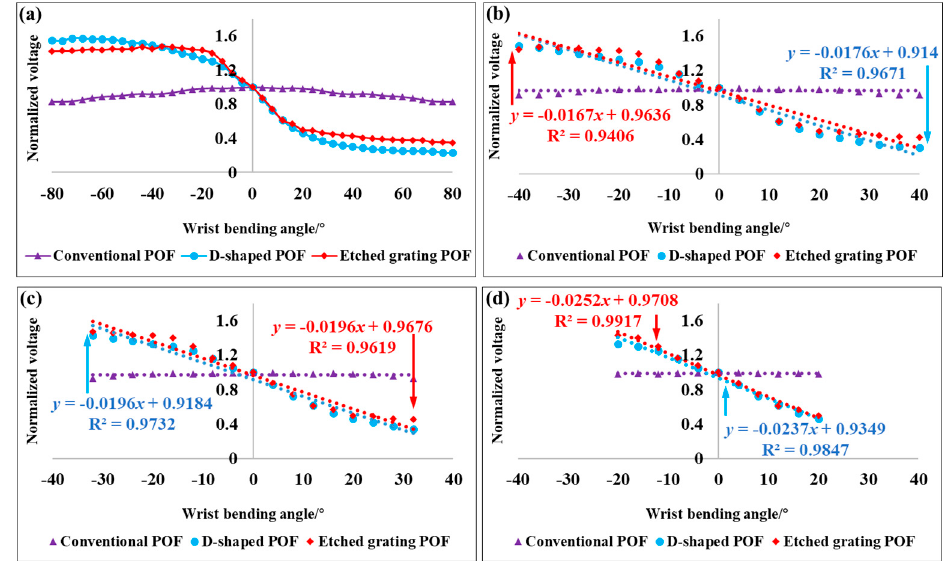
Figure 3. ( a ) The response to bending angle for the POFs with different sensitive structures. The measured normalized sensor output voltage at various angle ranges: ( b ) − 40°~+40°, ( c ) − 32°~+32° and ( d ) − 20°~+20°.